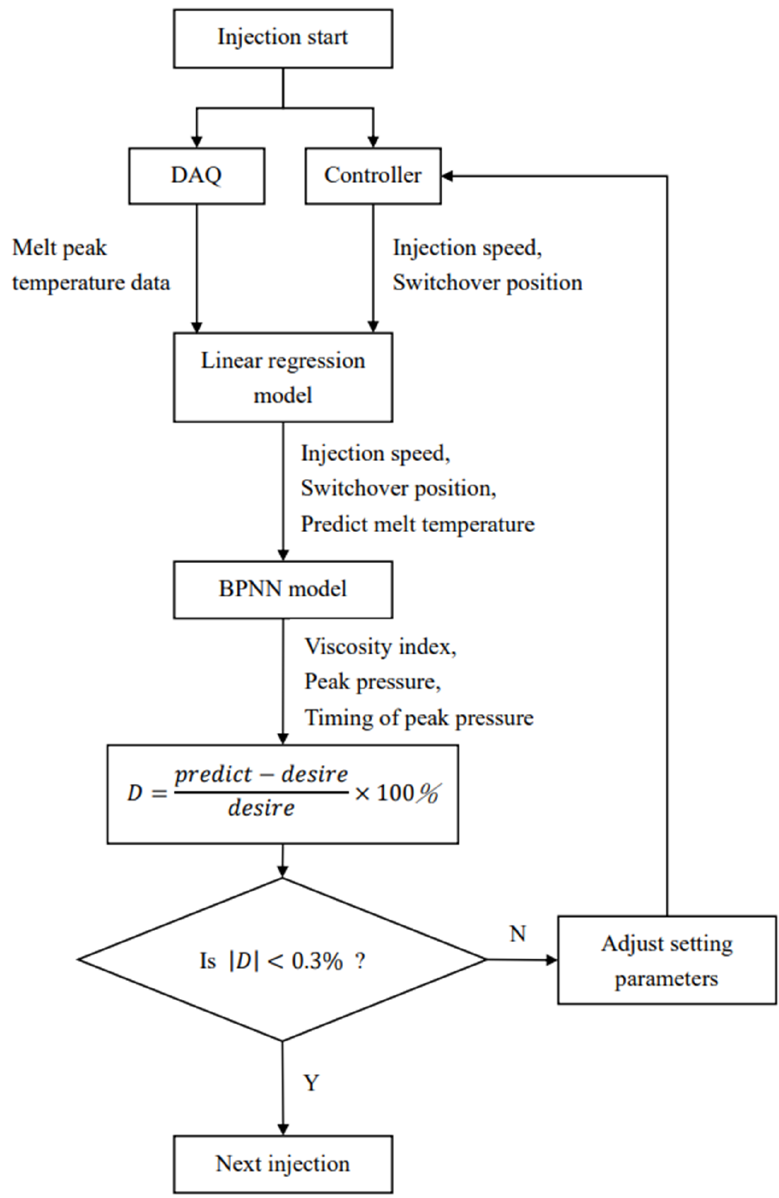
Figure 8. Flowchart of adaptive control strategy .